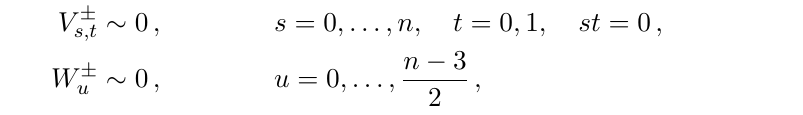
) = (3 , 4) , whereas more results with ( n, N f ) SU( N ) flavor fugacities are all omitted for simplicity. The f t × f u = 3 nN 4 n − 2 c f − N c −